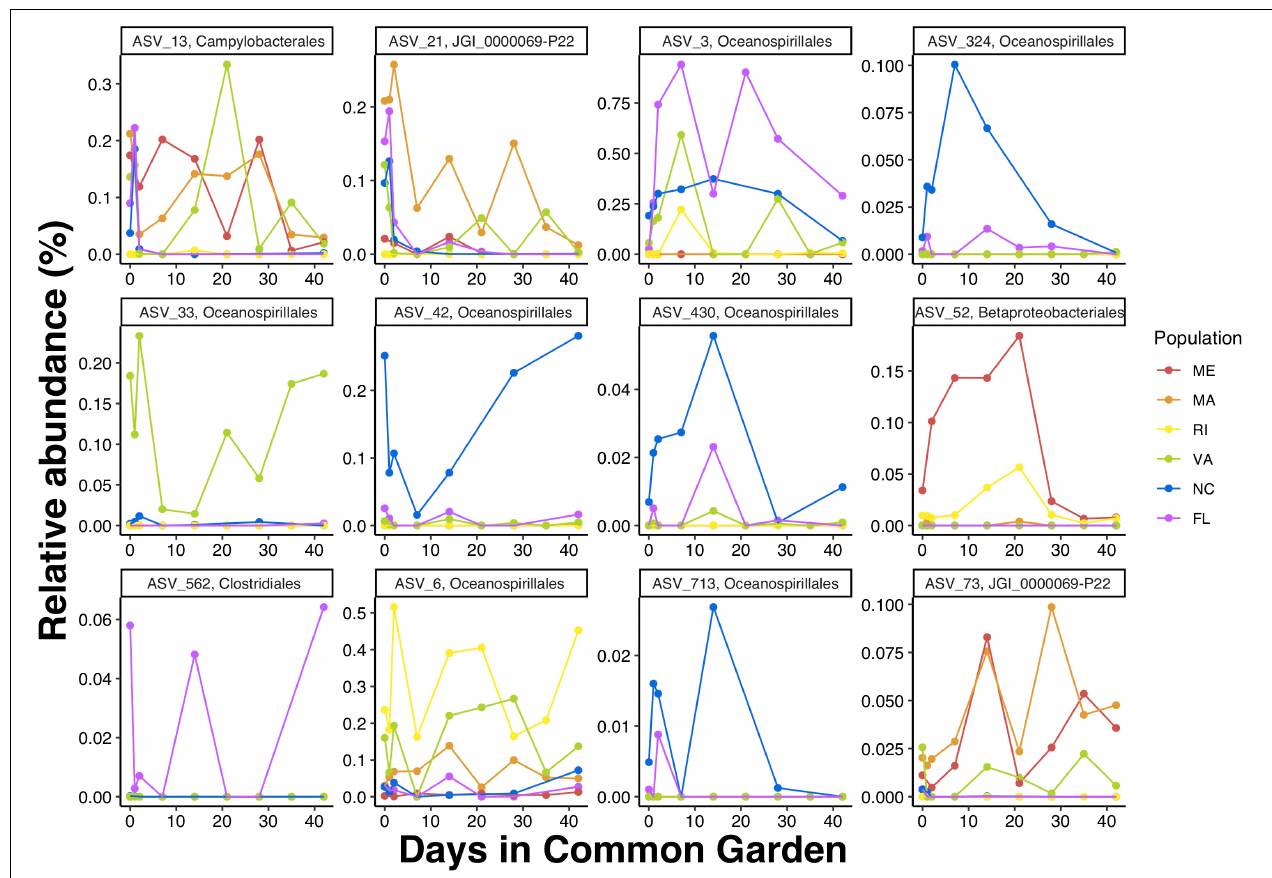
FIGURE 7 | Mean relative abundances by timepoint of ASVs with the top 1% FS (i.e., FS > 1). Detailed taxonomic information form these ASVs is available in Supplementary Table 3